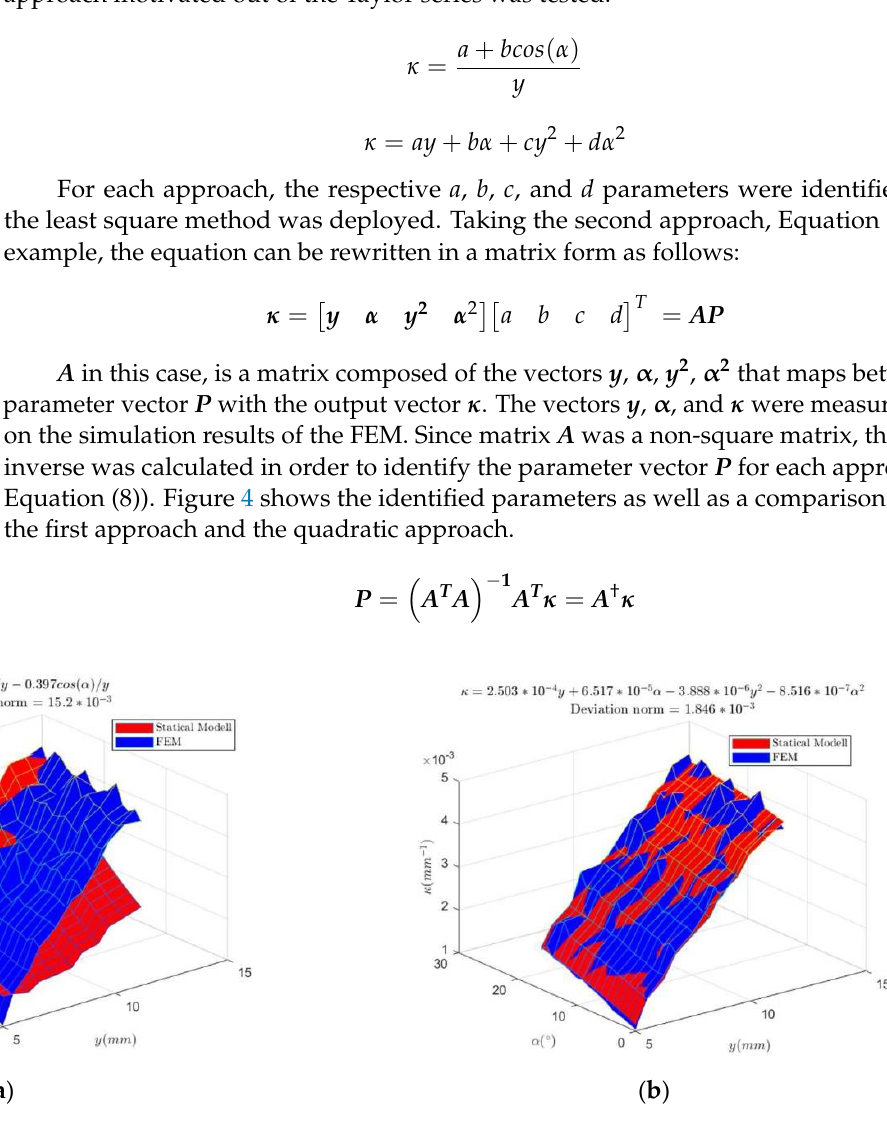
Figure 4. ( a ) First approach motivated out of the kinematic model in Equation (5), ( b ) Quadratic approach, Equation (6).